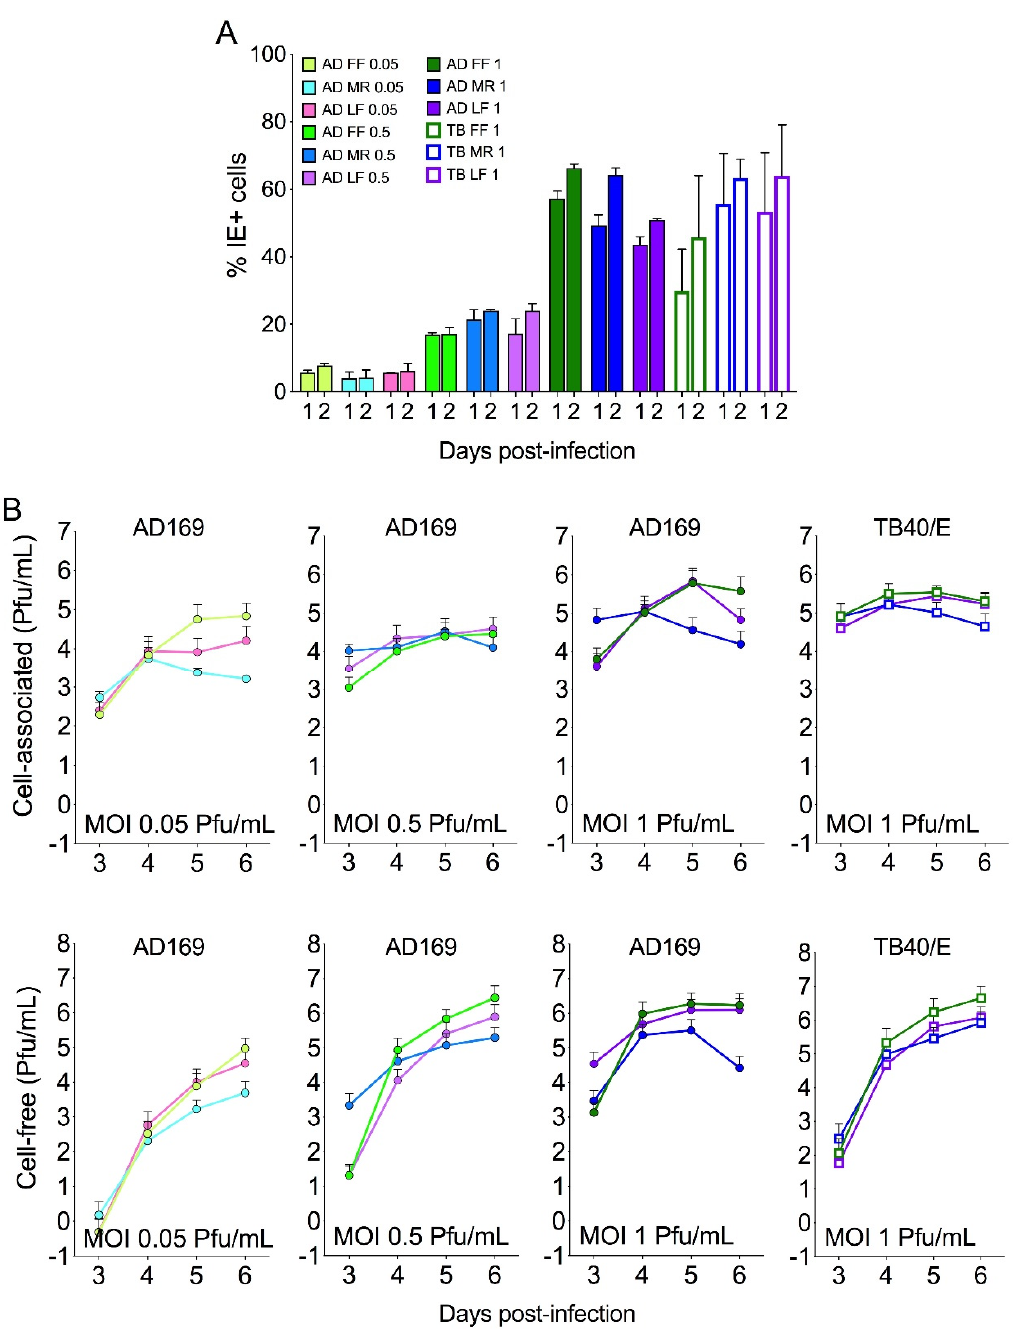
Figure 2. Infection and replication of CMV strains AD169 or TB40/E in LF, FF, or MR cultures. Confluent cultures in 24-well plates were exposed to AD169 (AD) at an MOI of 0.05, 0.5, or 1 pfu/cell, or to TB40/E (TB) at an MOI of 1 pfu/cell. Inoculum amounts were calculated based on the number of cells present in one well of each cell type at day zero (before infection). At each of the indicated days post-infection, cells and supernatants were collected and used to determine the proportion of nuclei expressing the IE1/IE2 proteins (% IE+, panel A ) or the amounts of cell-free or cell-associated progeny produced by each culture, as titrated on FFs (panel B ). Mean and standard deviation values from two (AD169) or four (TB40/E) separate experiments are shown.